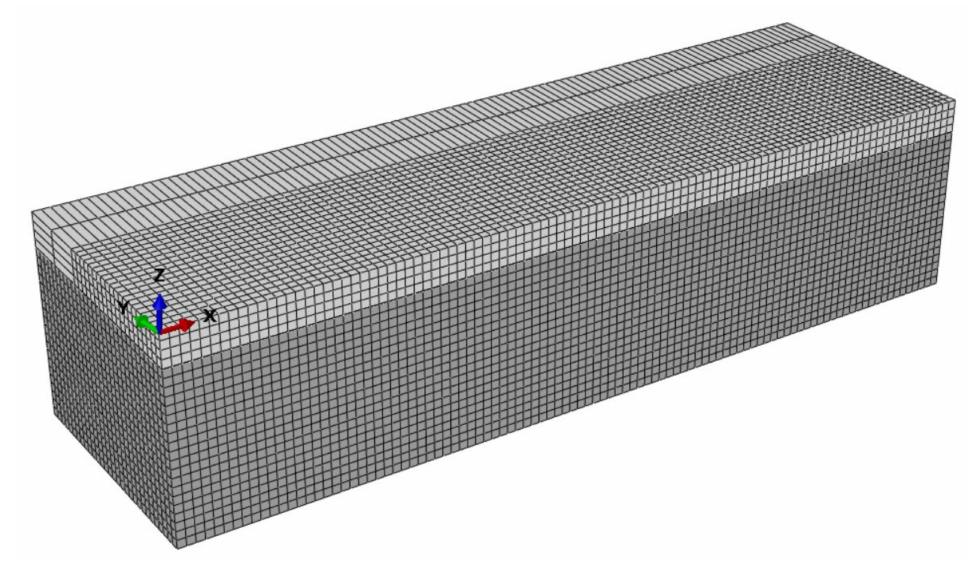
Figure 2. Single-track model